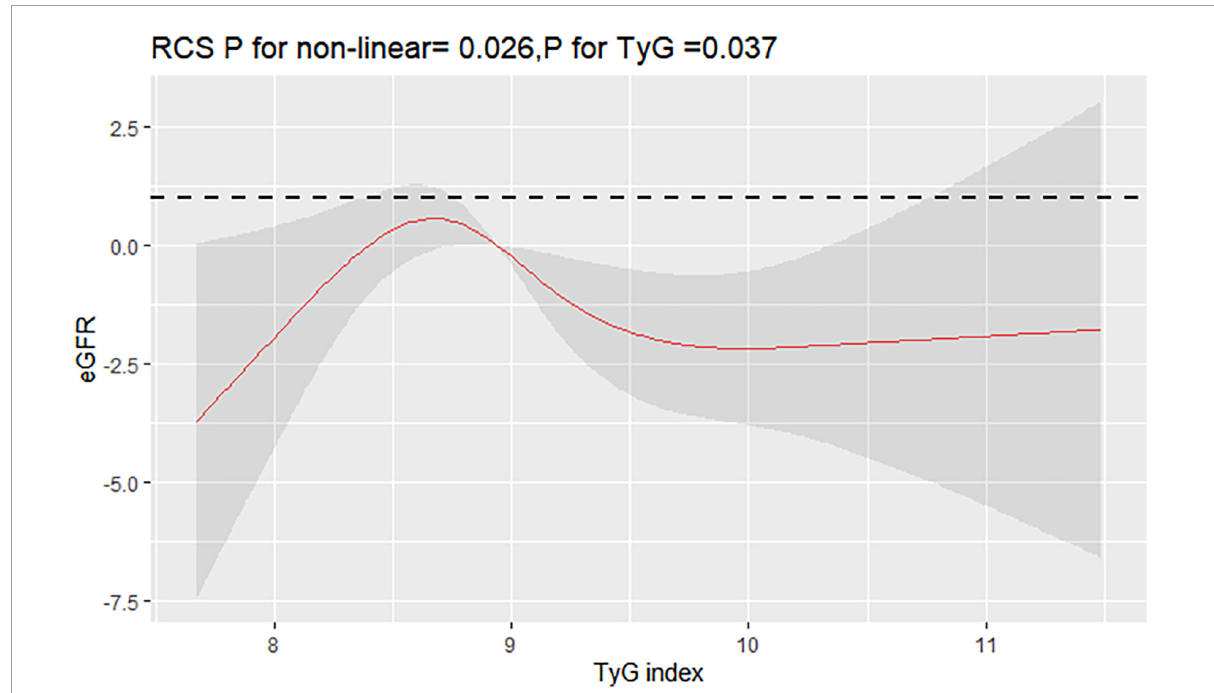
FIGURE4 Restricted cubic splines (RCS) for the shape of the association of TyG with eGFR. It was used a multivariate linear regression model of RCS with 4 knots (at the 5th, 35th, 65th, and 95th percentiles) of TyG adjusting for potential covariates (the same as Figure 3 ). The curve was centered at the median value of 8.94.